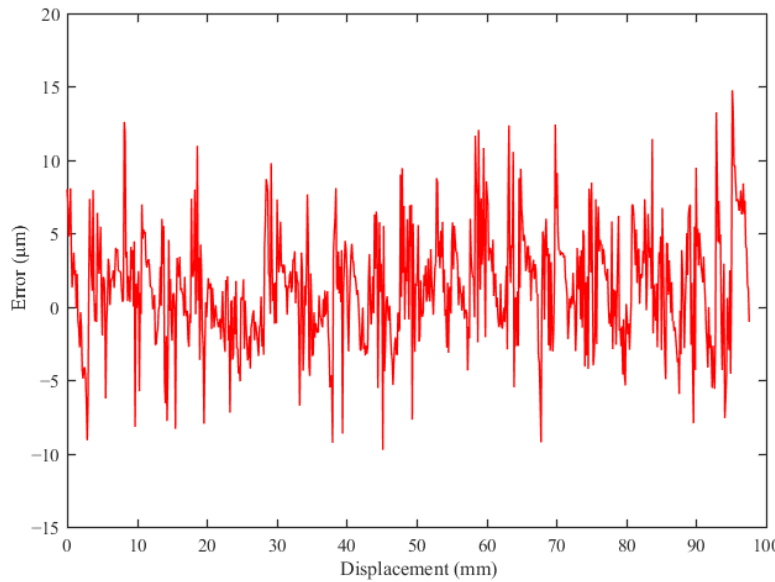
Figure 12. Sensor displacement measurement error.